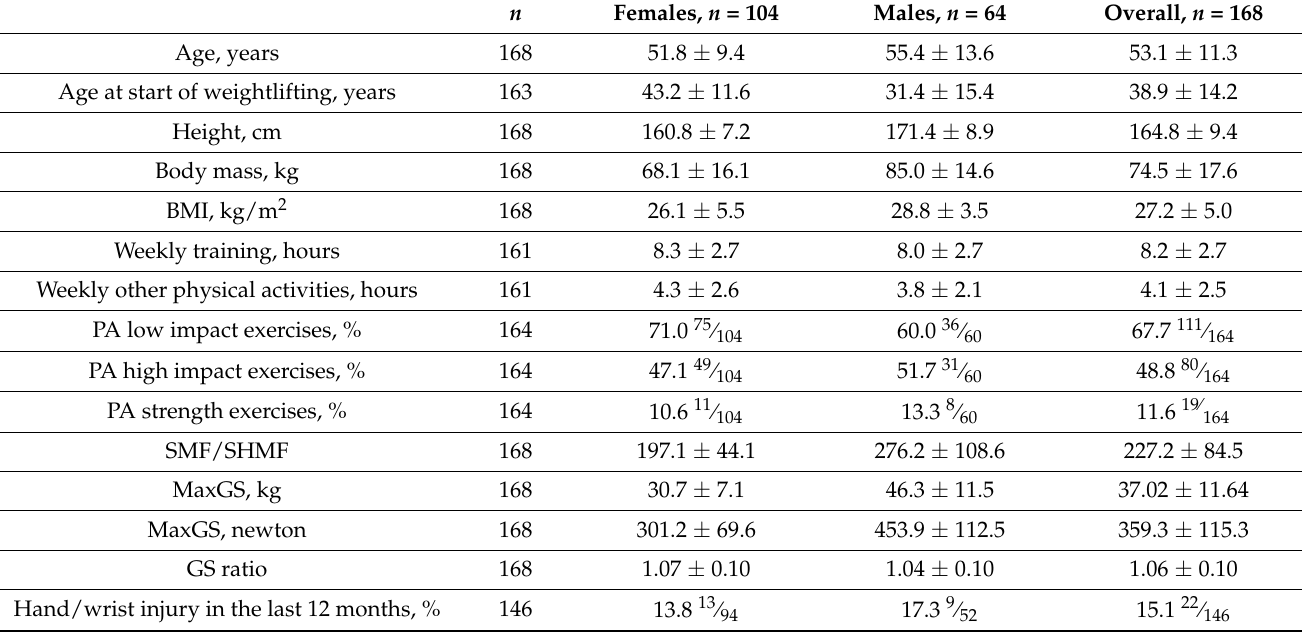
Table 1. Characteristics of the Master